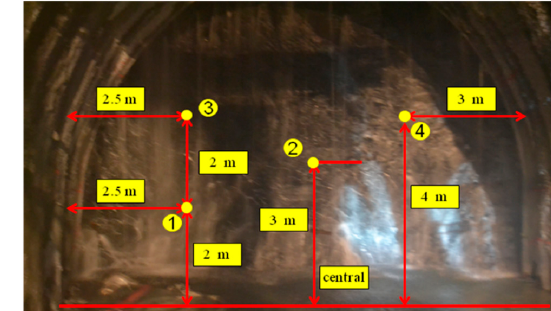
Figure 5. The drilling layout.